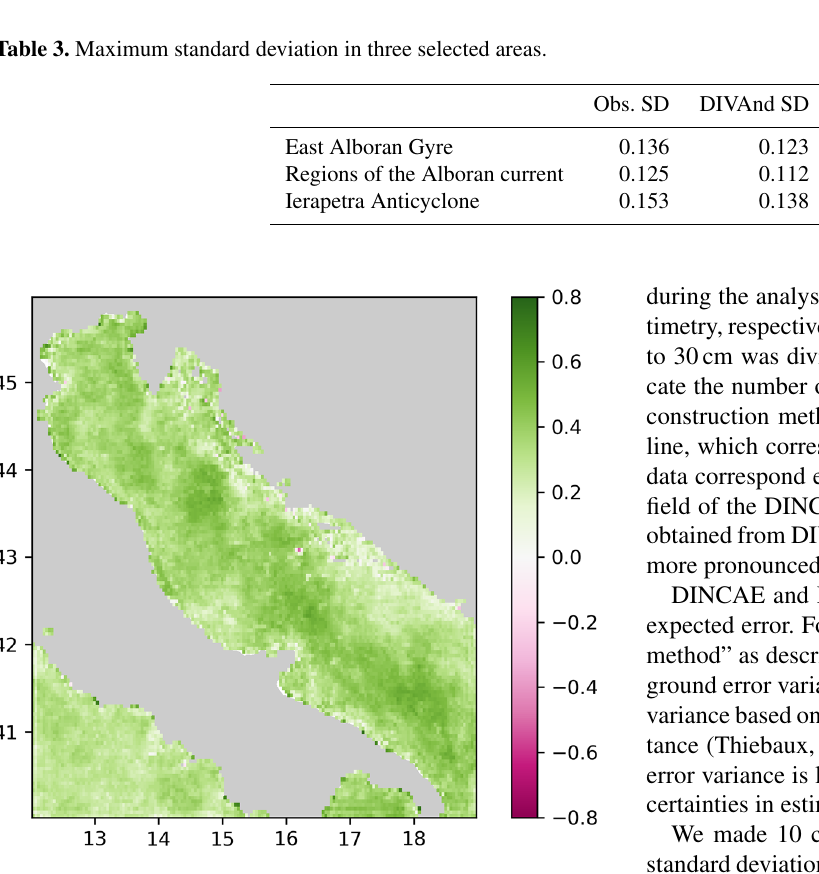
Figure 6. Mean square error skill score of the monovariate recon- struction corresponding to DINCAE 1.0 and the multivariate case (considering all variables) and with an additional refinement